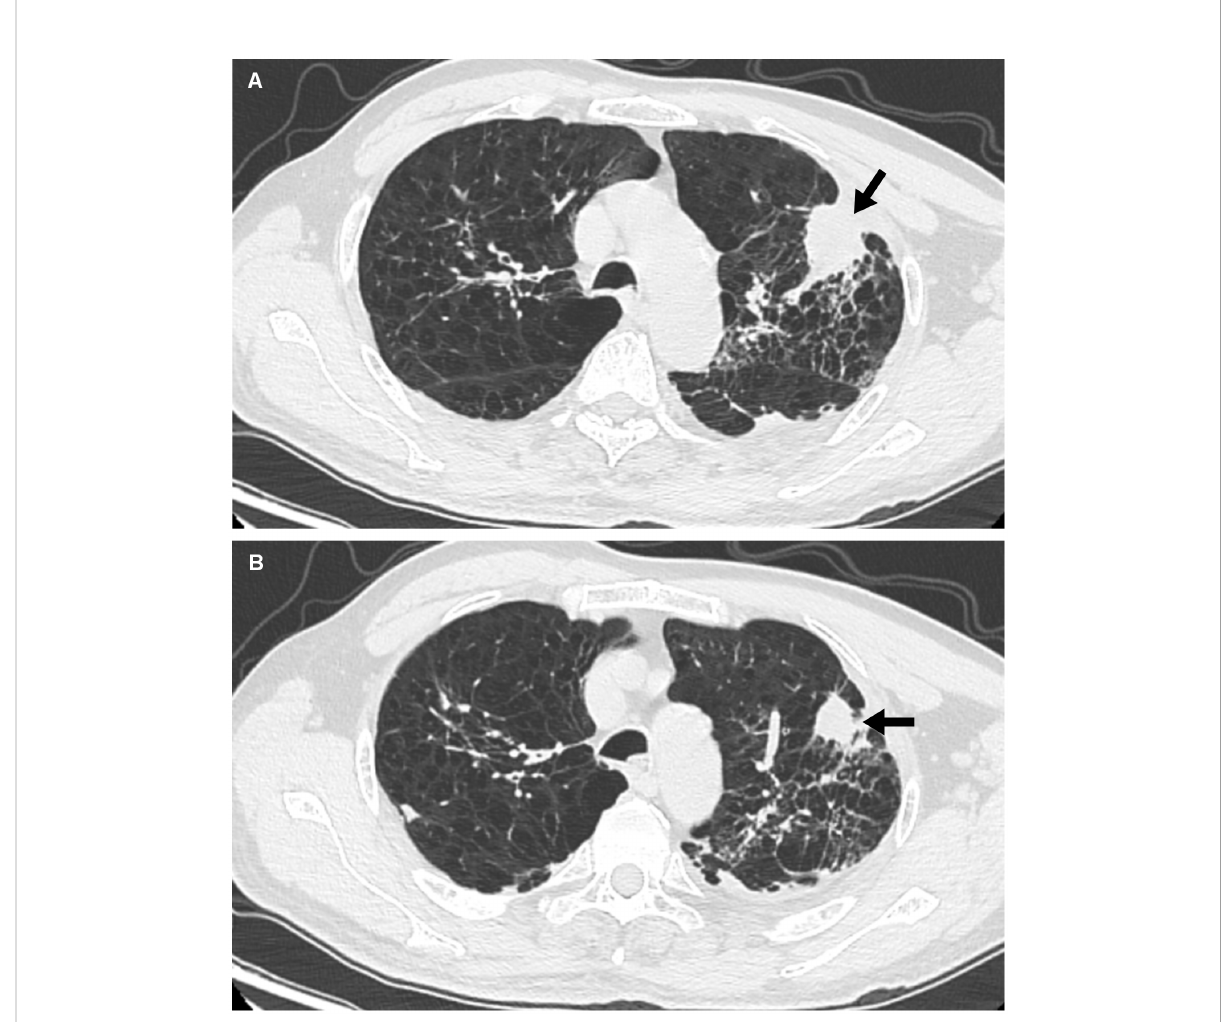
FIGURE 1 Findings of chest CT. (A) Image from chest CT shows a mass (arrow) in the apicoposterior segment of the left upper lung before ICIs therapy. (B) After one cycle ICIs treatment, the lung mass gradually shrank